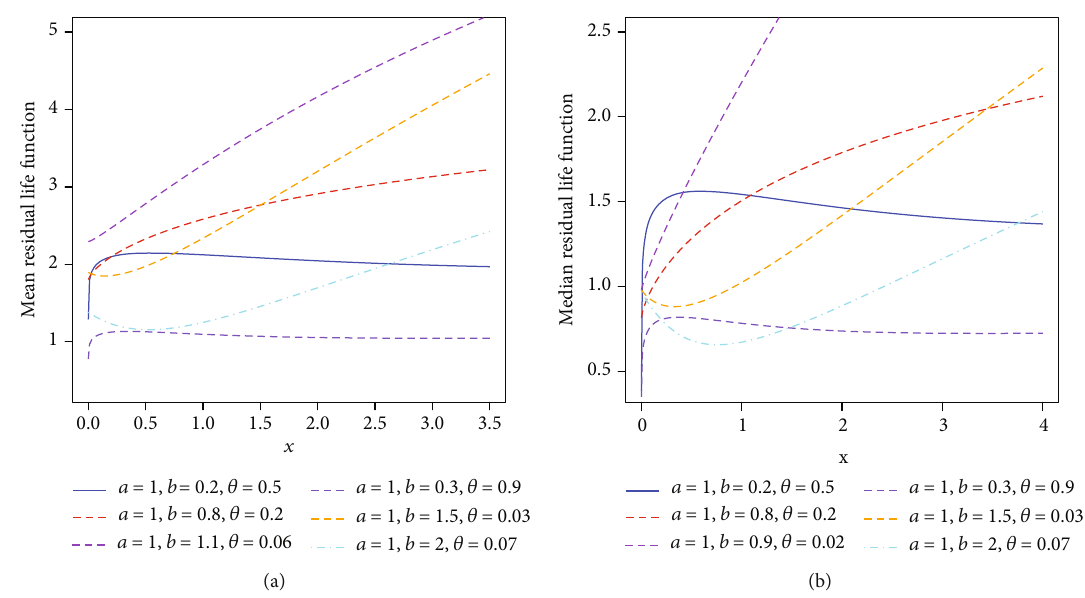
Figure 2: The MRL (a) and the median residual life function (b) of the MLL for some parameter